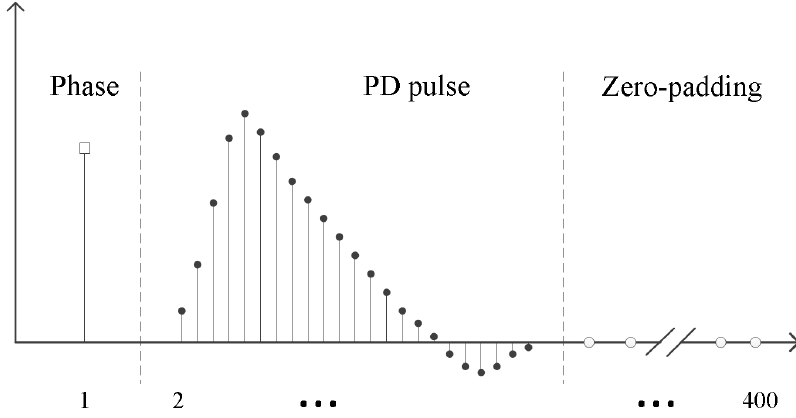
Figure 14. Schematic diagram of the feature normalization.